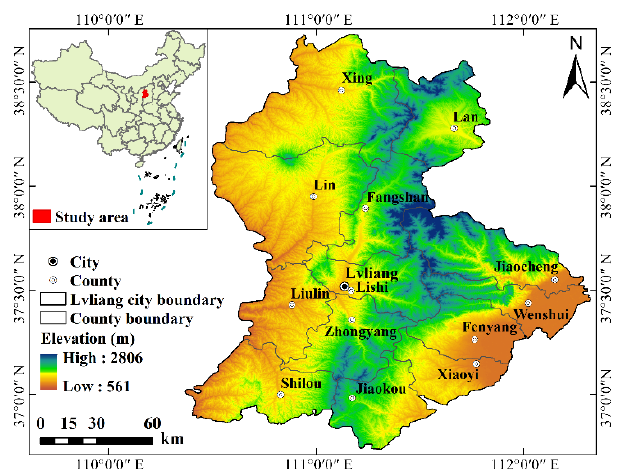
Figure 1. Location and elevation of study area.